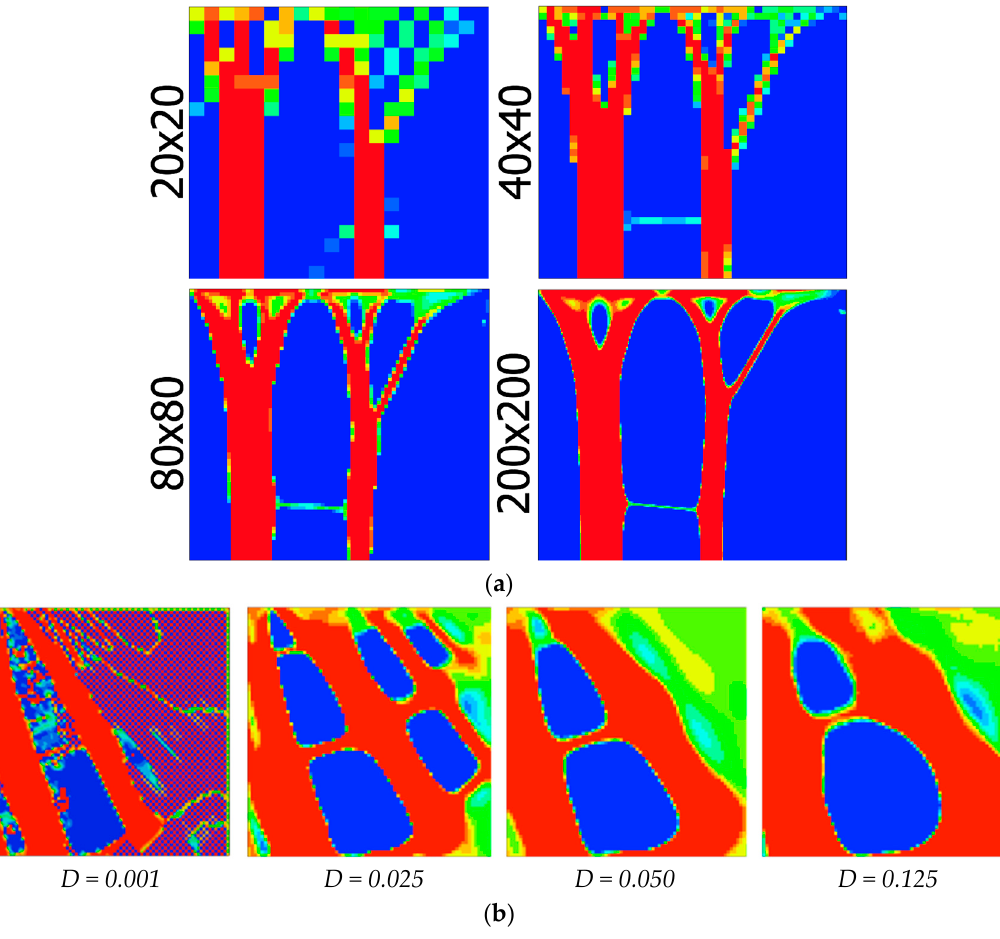
Figure 5. Bone tissue adaptation models working on the basis of homeostasis and driven by the strain energy density were implemented in finite element models to determine the distribution of density and, thus, mechanical properties under different loading conditions. The patterns emerging from such bone tissue adaptation algorithms (red = high bone density, blue = low bone density) are similar in shape and function to those resulting from topology optimization algorithms and could be used both for the general design of AM parts as well as for the patient-specific design of micro-architecture in AM porous implants ( a ). The level of detail could be adjusted using a coefficient, D , that regulates the size of the influence domain of the osteocytes ( b ) (Researcher at TU Delft: Gianni Campoli) (Reprinted from [104] with permission from Elsevier).